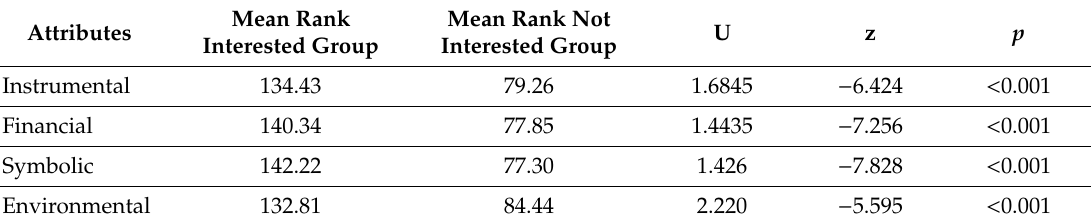
Table 6. Results of Mann–Whitney U tests on evaluations of EV